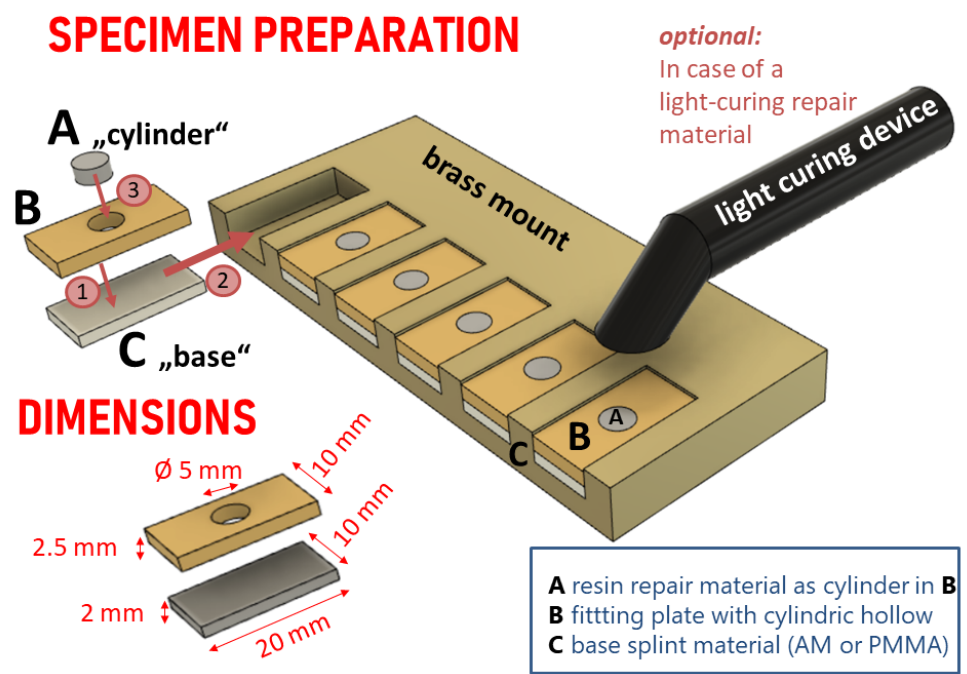
Figure 2. Schematic drawing of the device to facilitate the bonding of the repair material ( A ) within a cylinder to the base polymer ( C ) with help of a fitting plate ( B ). Fitting plate was laid on top of the base material and assembled in the slots of the brass mount. Thereafter the repair material was applied to the cylindric hollow in B. In case of light curing resin materials, it was performed initially with a handheld lamp on each specimen and the brass mount was put into the light oven afterwards. For PMMA, the brass mount was put into the pressure pot.